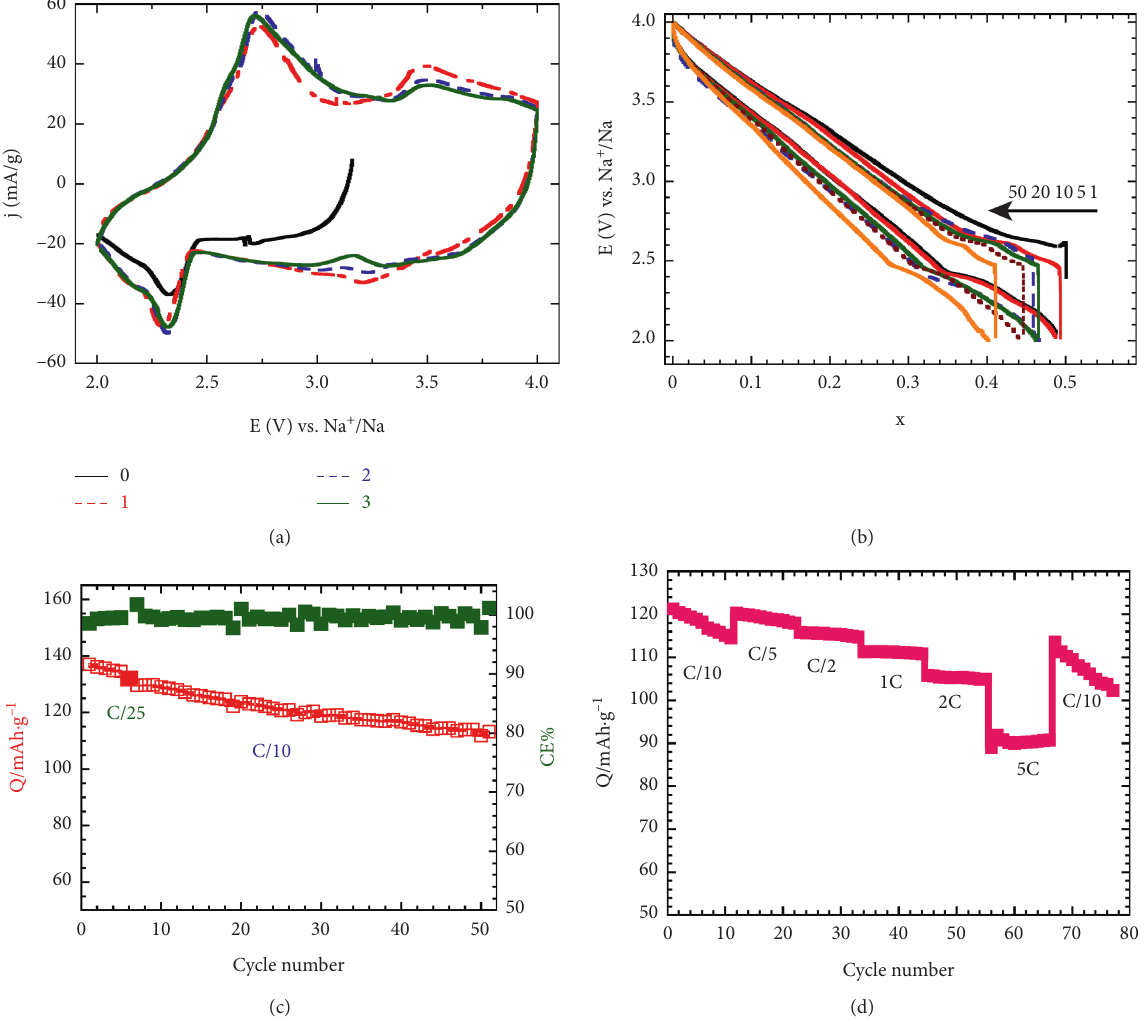
Figure 3: Electrochemical behavior of the sodiated Na z NMC in half-cell of Na || NaClO 4 /PC-FEC (98: 2) || Na z NMC. (a) CV curves at a scan rate of 0.1 mV s − 1 . (b) The galvanostatic charge–discharge profiles at the rate of C/25 and C/10. (c) The specific capacity and Coulombic efficiency versus cycles and (d) rate capability